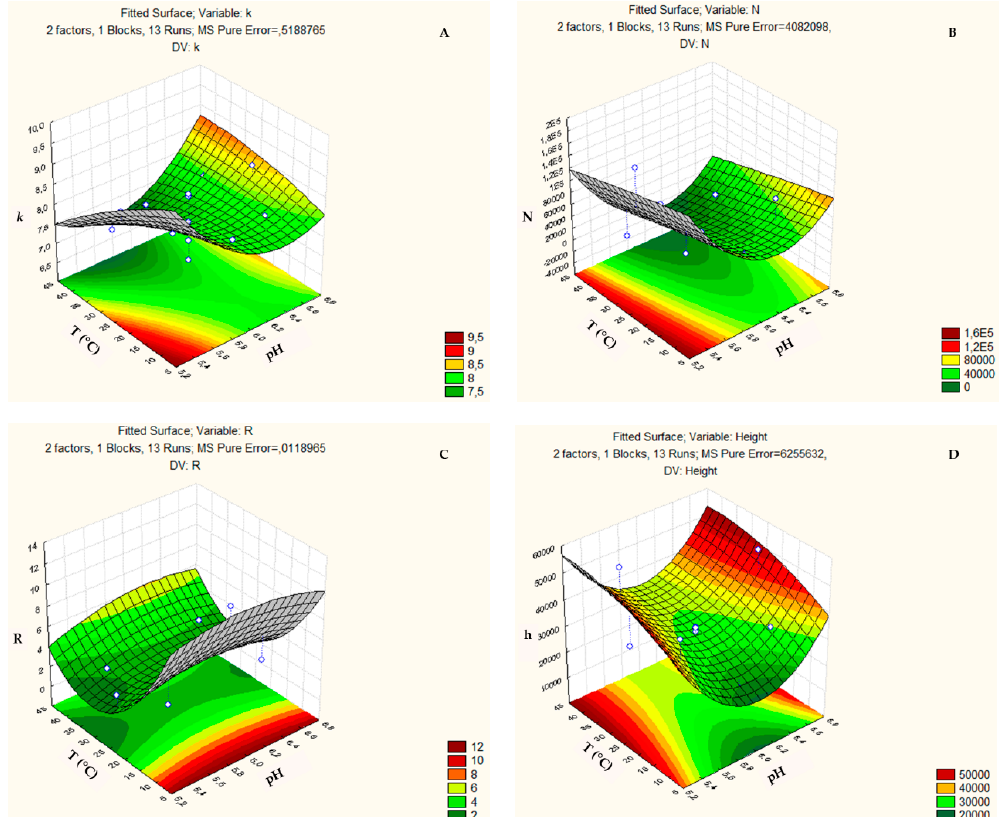
Figure6. Three-dimensionalresponsesurfaceplotshowingthee ff ectsofthemutualinteractionsbetween two independent variables pH and Temperature on ( a ) Retention factor ( k ); ( b ) Column e ffi ciency (N); ( c ) Resolution (R); and, ( d ) Height (h) of the chromatographic analysis on the ZIC-HILIC